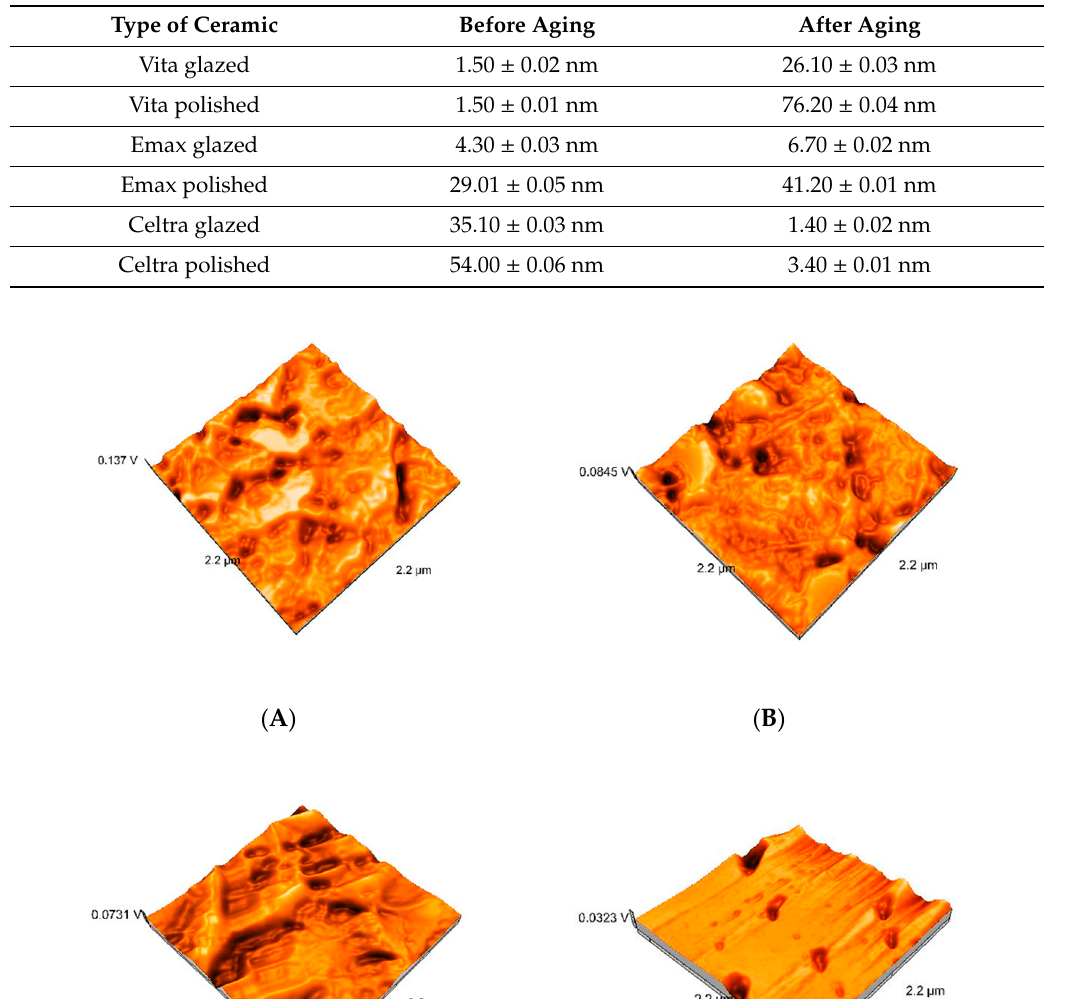
Table 8. Sq (nm) values before and after thermocycling.